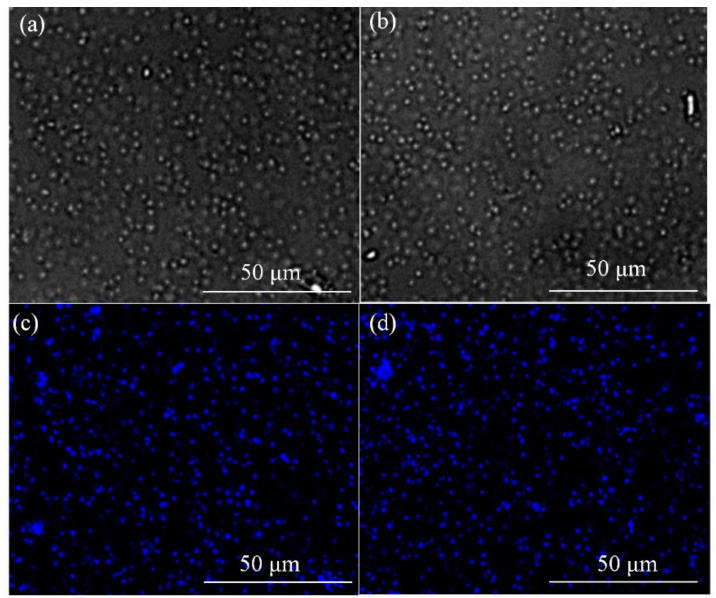
Figure 8. Fluorescence image of Klebsiella sp. cells incubated with wh-CQDs (500 µ g/mL) for 12 h under ( a – b ) bright field and ( c – d ) excitation wavelength of 375–407 nm.